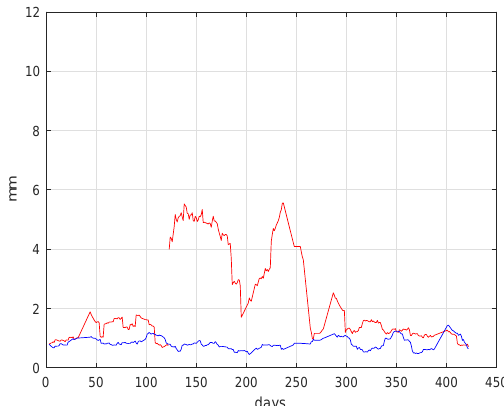
Figure 18. Modelled zenit of the line connecting the West and East points during the observed period